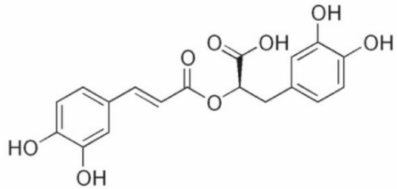
Figure 2. Rosmarinic acid